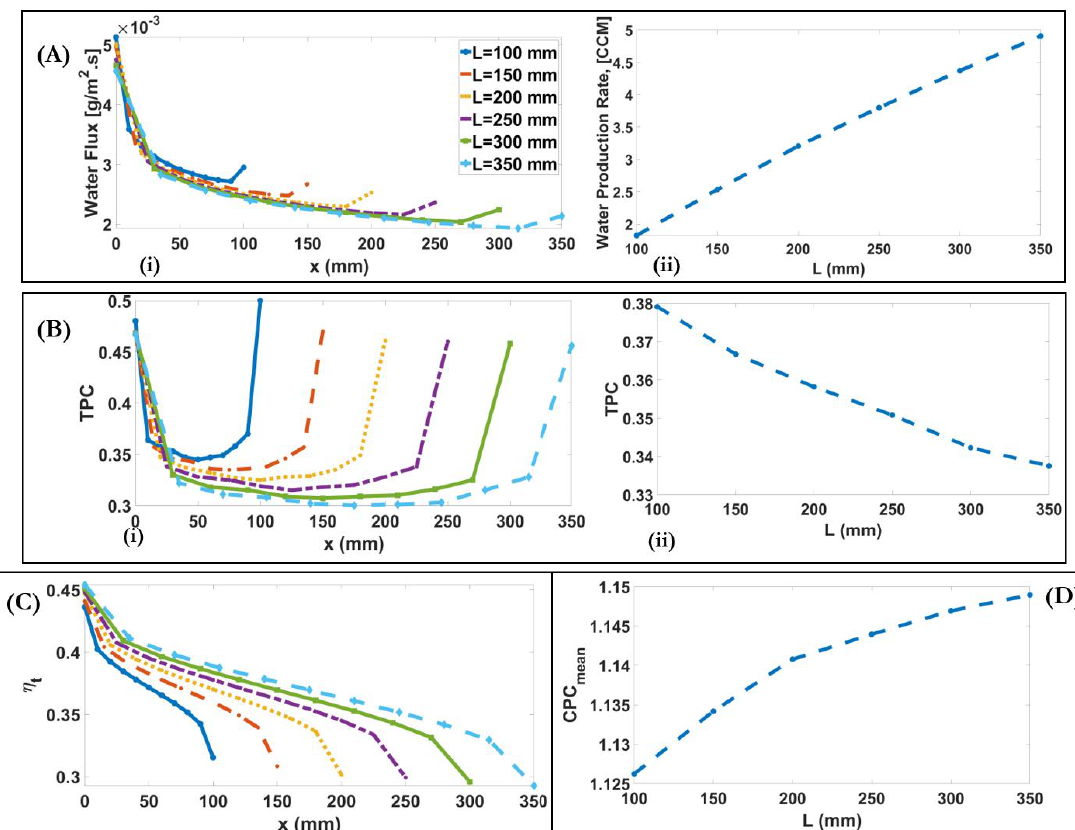
Figure 11. ( A ) ( i ) Downstream alterations of water flux for different channel lengths; ( A ) ( ii ) Alteration of water production rate with varying channel lengths. ( B ) ( i ) Downstream alterations of TPC for different channel lengths; ( B ) ( ii ) Alteration of mean TPC with varying channel lengths. ( C ) Alteration of thermal efficiency with varying channel lengths ( D )Alteration of CPC with varying channel lengths.